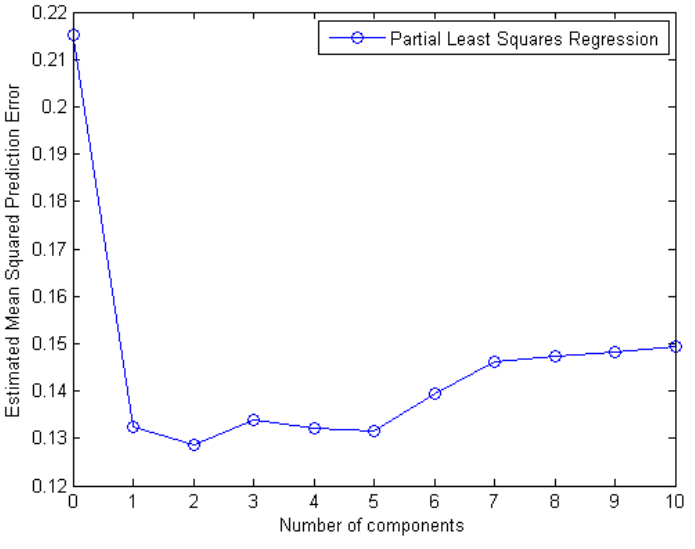
Figure 6. Mean squared prediction error as a function of the number of Partial Least Squares Regression components.